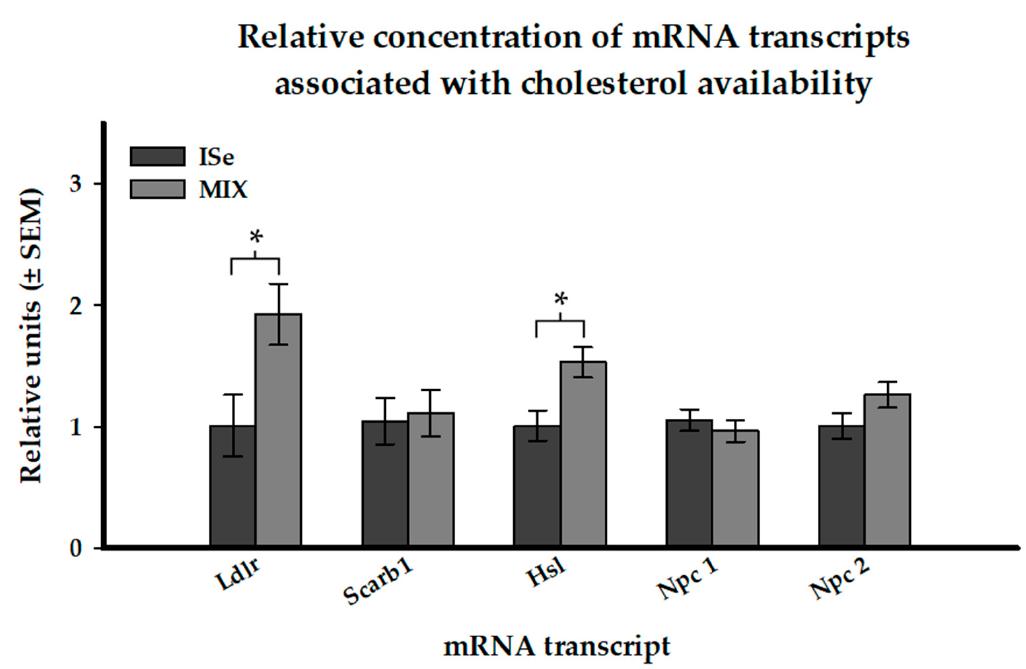
Figure 6. Effect of form of Se on the expression of mRNA transcripts associated with the availability of cholesterol in the CL of cows supplemented with Se in vitamin mineral mixes as ISe (sodium selenite; n = 5) or a 1:1 combination (MIX) of ISe and OSe (Sel-Plex; n = 5). p -values are associated with Student’s t -test. Significant differences at p < 0.05 are indicated by an asterisk.